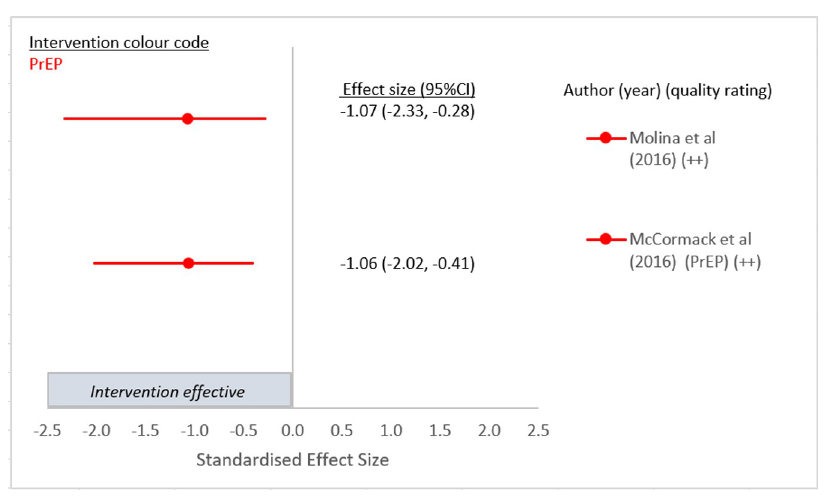
Fig 2. Intervention effect on HIV incidence.